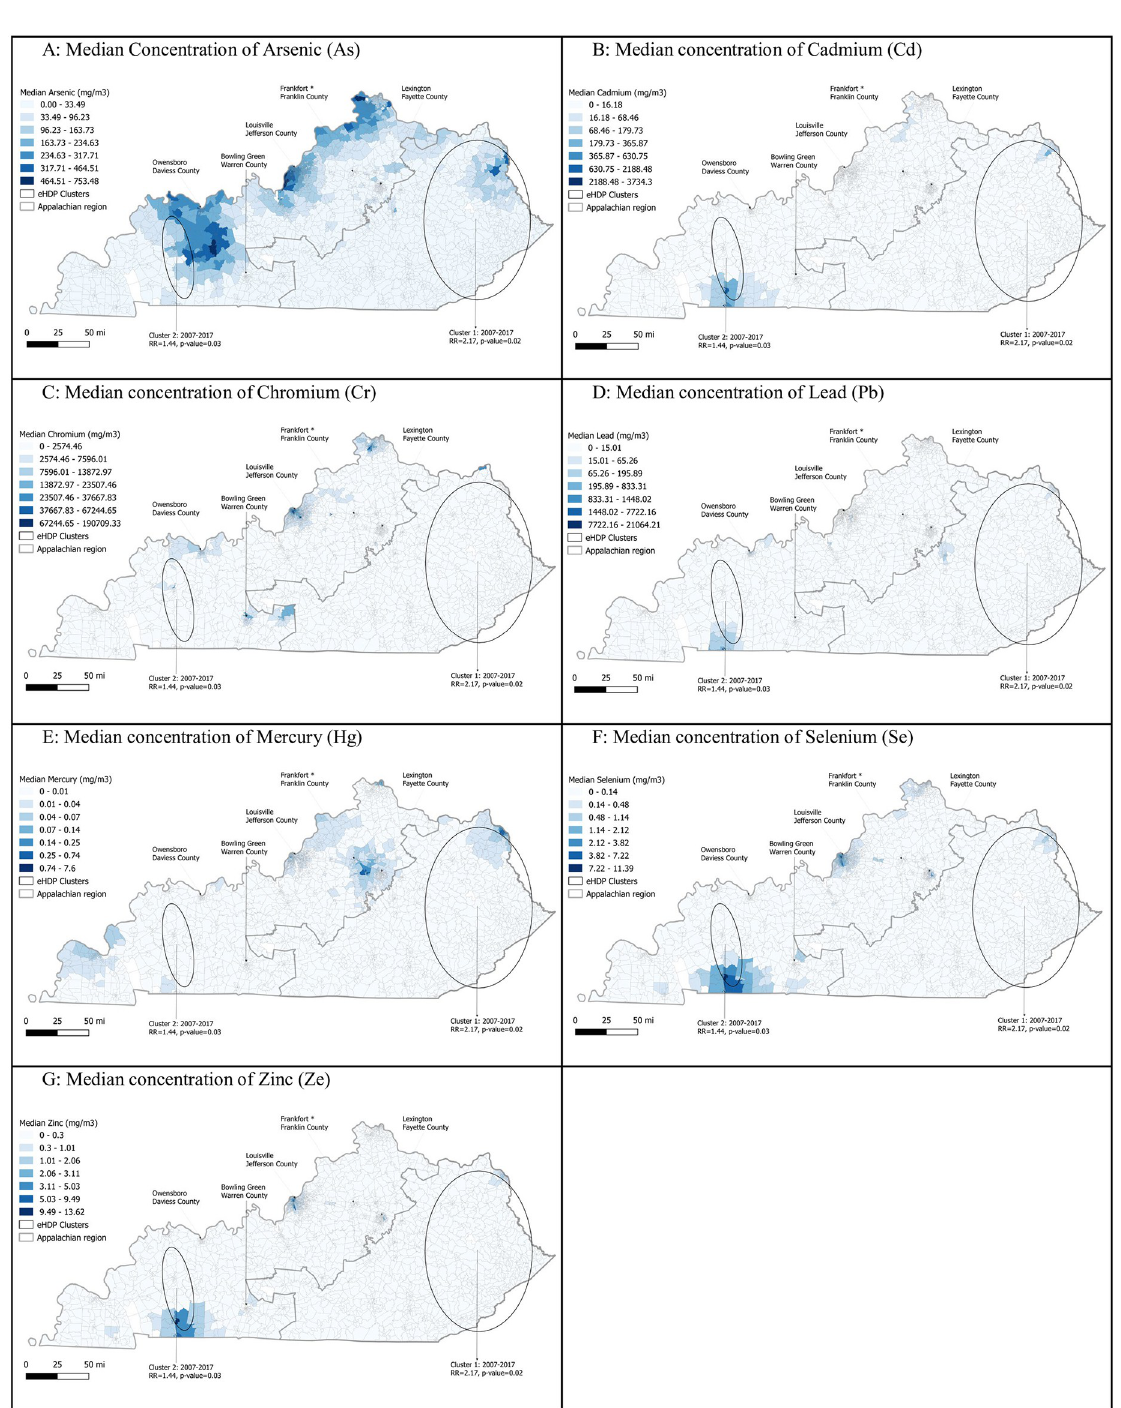
Fig 2. Median toxicity concentrations of emissions for each census block group, Kentucky 2007–2017.